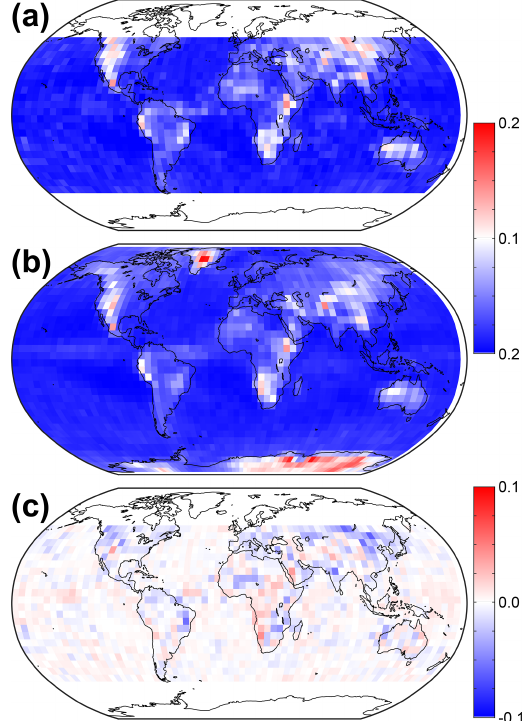
Figure A3. Global distribution of the fraction of mid-level clouds in observations with the (a) CATS and (b) CALIPSO lidars and (c) difference between CALIPSO and CATS for the time period from March 2015 to October 2017. Only CATS data within ± 1h around the fixed CALIPSO overpass times are considered.